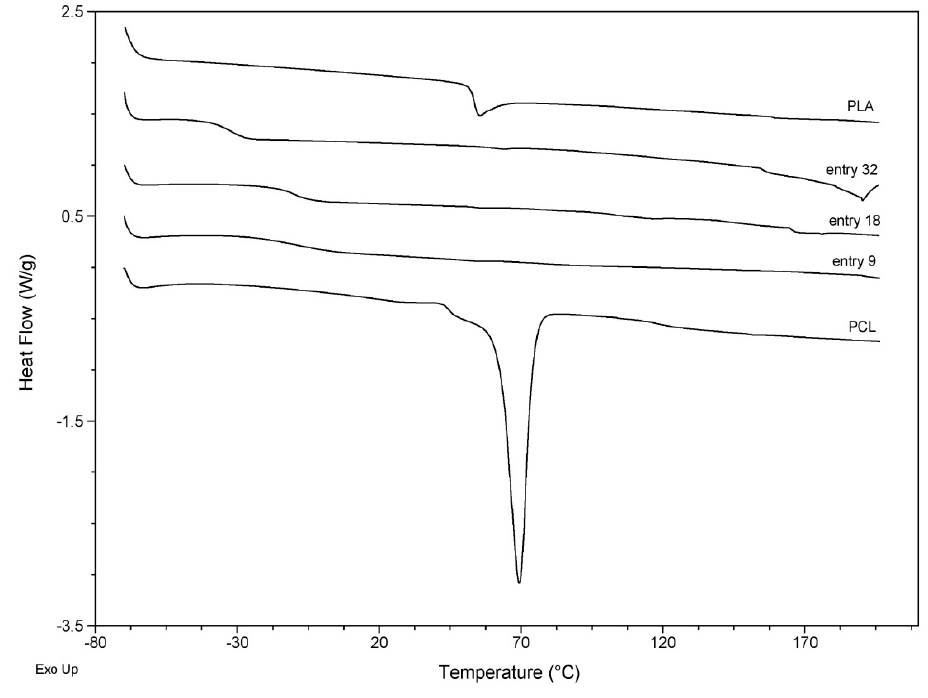
Figure 3. DSC curves of the selected samples and references. Table 2. Di ff erential scanning calorimetry (DSC) results of the selected copolymers and